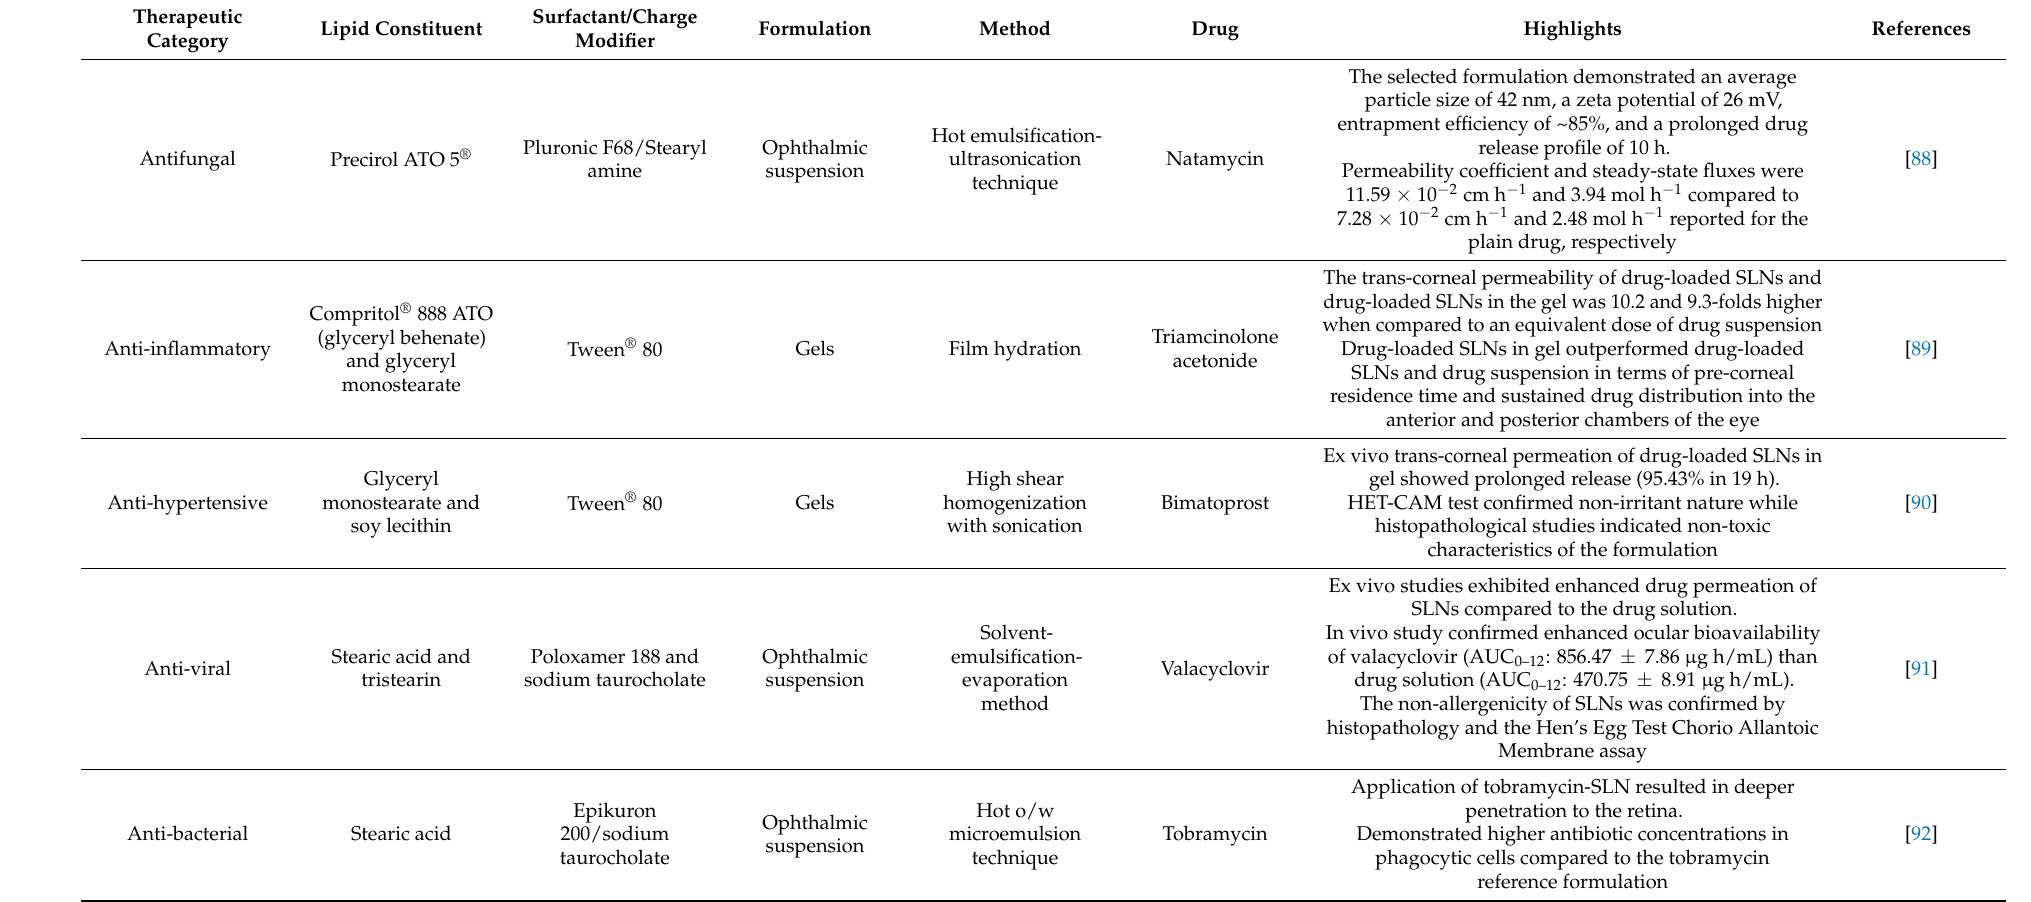
Table 3. Examples of solid-lipid nanoparticles in ocular drug delivery and their